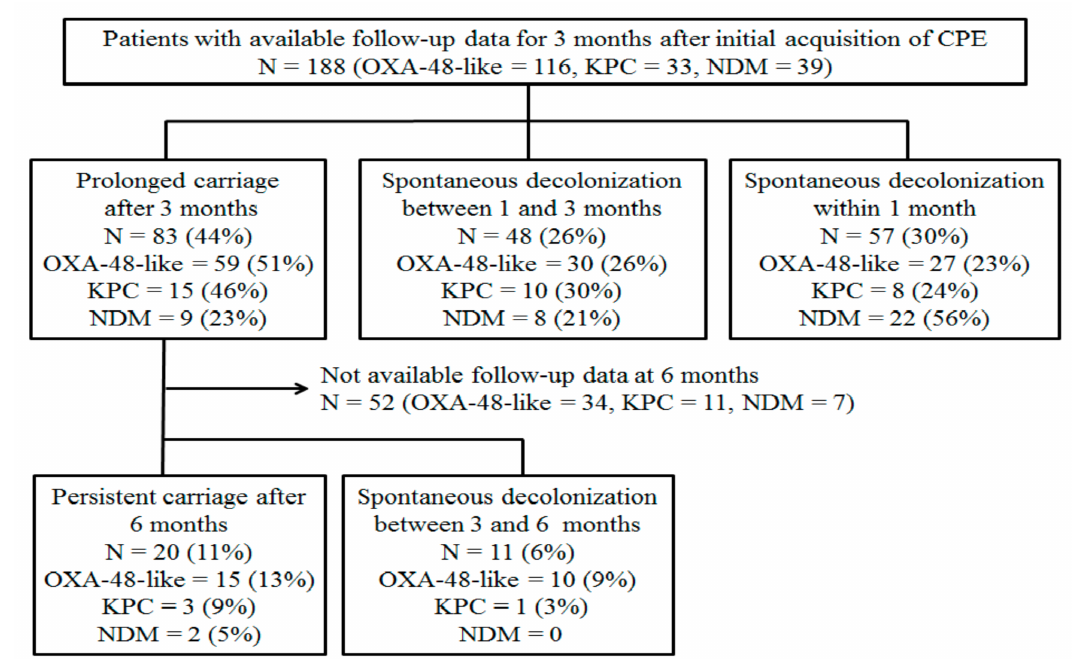
Figure 3. Flow chart of included patient with available follow-up culture data for 3 months after the initial detection of CPE to evaluate the clinical factors associated with prolonged